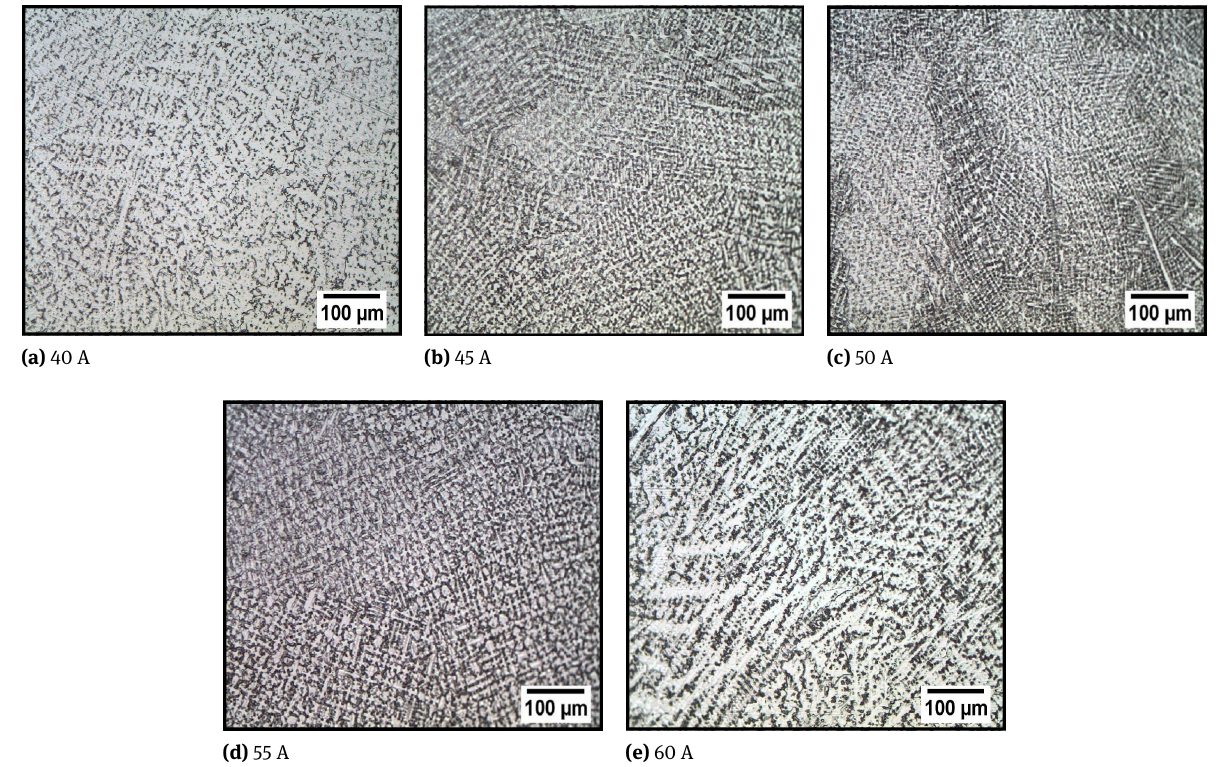
Figure 13: Effect of Delta Current on fusion zone (FZ)